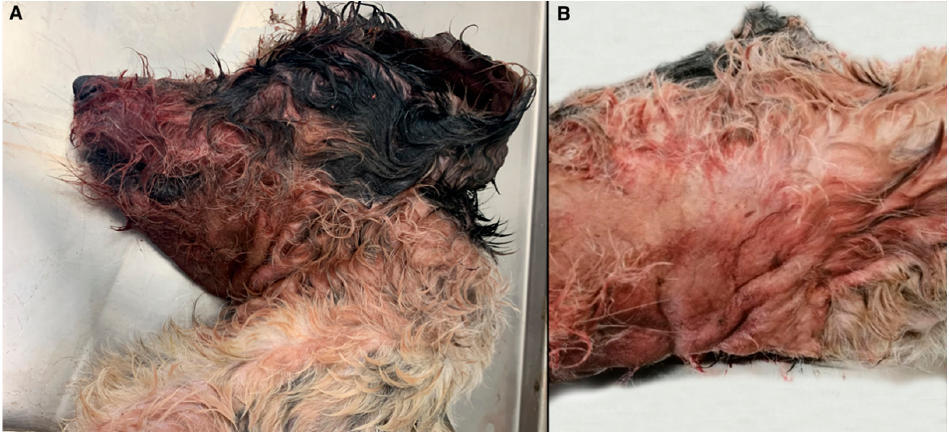
Figure 1. Gross examination of the infected dog. Self-inflicted cutaneous lesions around the muzzle, ears, and neck probably secondary to intense itching ( A ). Diffuse oedema was observed in the region of the neck ( B ).